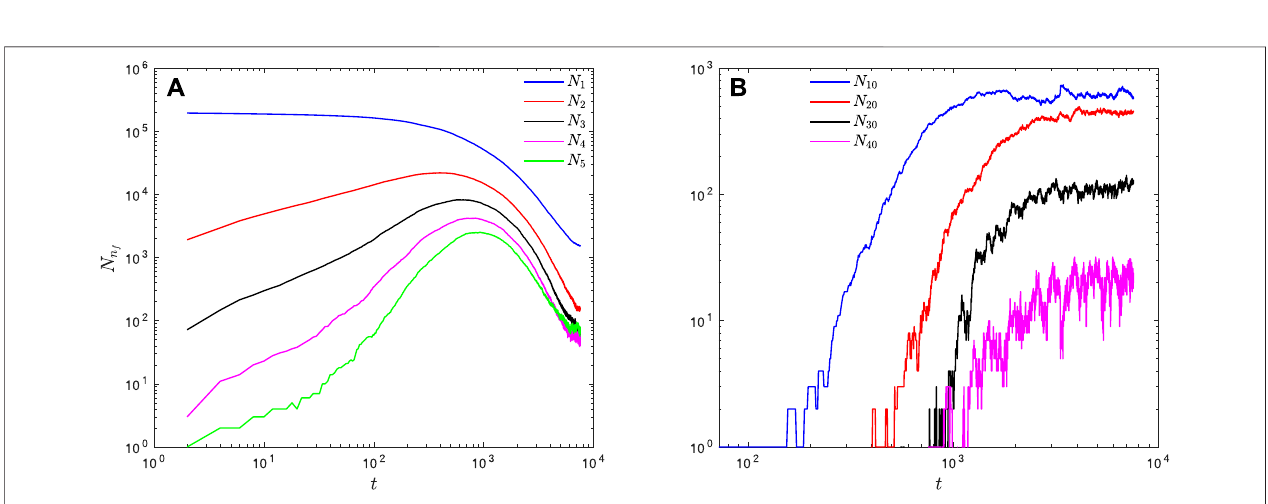
FIGURE6| Timeevolutionof fl ocpopulation N n forgiven fl ocsize n f fromcase P 2 S 2 . (A) Small fl ocsofsize n f =1to5. (B) Large fl ocsofsize n f =10,20,30,and40. f